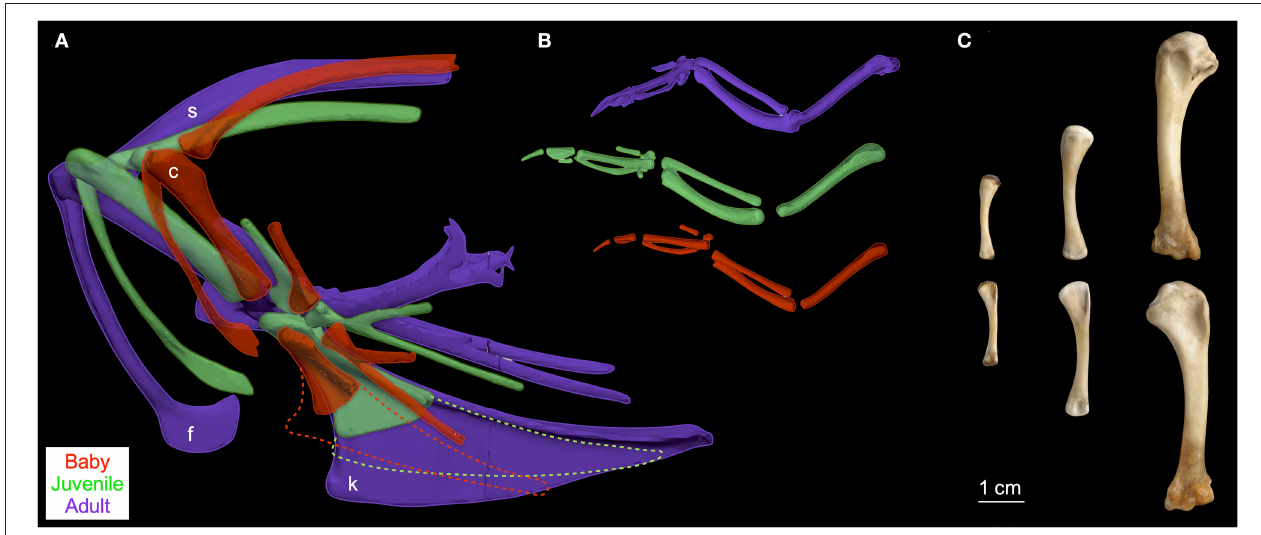
FIGURE 2 | Pectoral girdle and forelimb ontogeny. During avian ontogeny, elements of the pectoral girdle (A) and forelimb (B,C) change in relative size, orientation, and/or complexity. Pectoral girdles of chukars (A) shown in left lateral view and standardized by notarium length; notaria (not shown) oriented horizontally and positioned by aligning the coracosternal joints to clearly show changes in bone orientation; k (keel of sternum; cartilaginous components dashed), f (furcula), c (coracoid), s (scapula). Left forelimbs of chukars (B) shown in dorsal view ( ∼ perpendicular to deltopectoral crest) and mid-downstroke posture, also standardized by notarium length but not to scale with (A) . Left humeri (C) of baby, juvenile, and adult chukars shown in caudal (top) and cranial (bottom) views; photo by Nicole Wong.